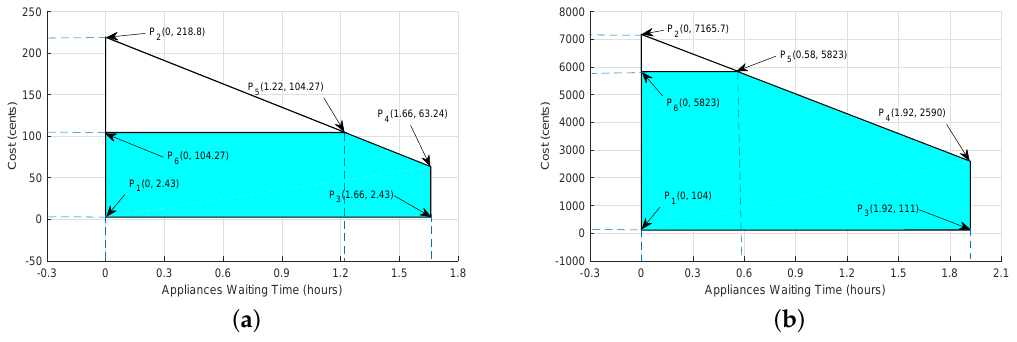
Figure 6. Feasible region for cost and waiting time RTP. ( a ) Feasible region for a single Home; ( b ) feasible region for multiple